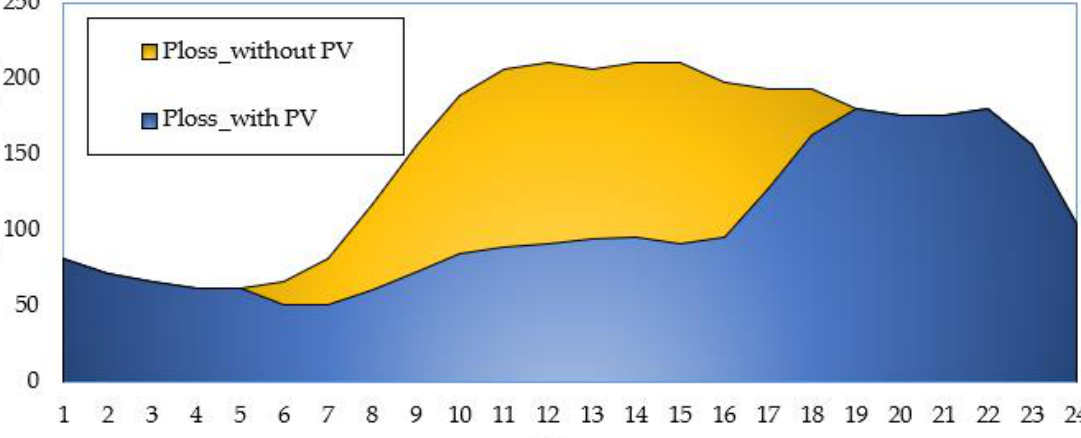
Figure 9. Hourly active power losses for the second scenario compared to the first scenario for the IEEE 33-distribution system.